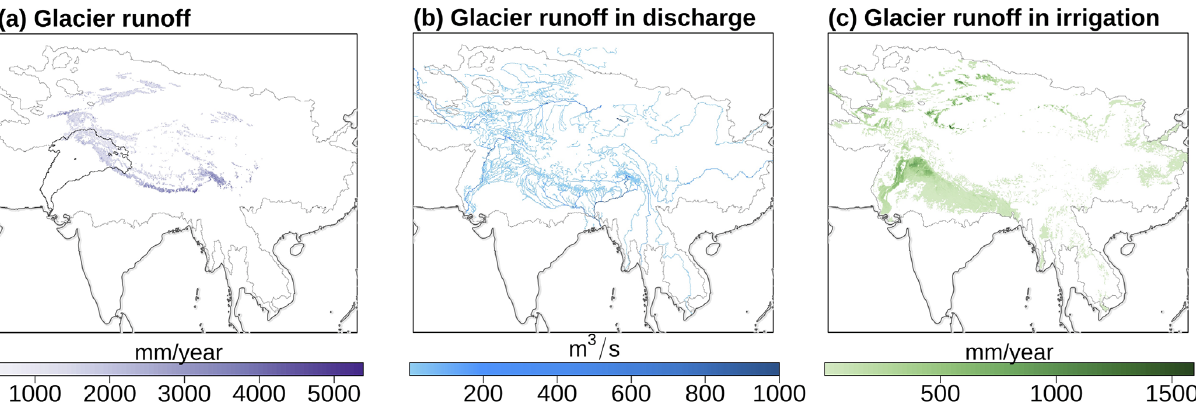
Figure 9. Tracking glacier runoff (a) downstream through rivers (b) and irrigation water use (c) in High Mountain Asia, a region where glacier meltwater is an important resource. While glacier water originates in the mountains, its use in agriculture is extensive due to re-use through the river network and shallow groundwater stores, and retention in and distribution from large reservoirs. The boundary of all High Mountain Asia basins with glaciers at their headwaters is shown in gray. Panel (a) also shows the Indus River basin boundaries for reference to compare with Fig.